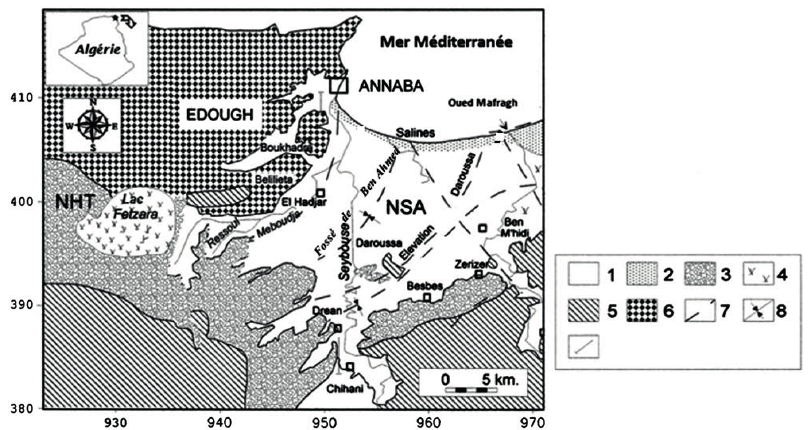
Fig.2 Geological map region Annaba-El Tarf (Aoun Sebaiti 2010). 1: Recent and actual Quaternary; 2: sandhills; 3: old Quaternary; 4: swamp or lake; 5: sandstone and Numidian clay; 6: Metamorphic formations; 7: faults; 8: trenches axis. Table 1 Climatic characteristics of the studied